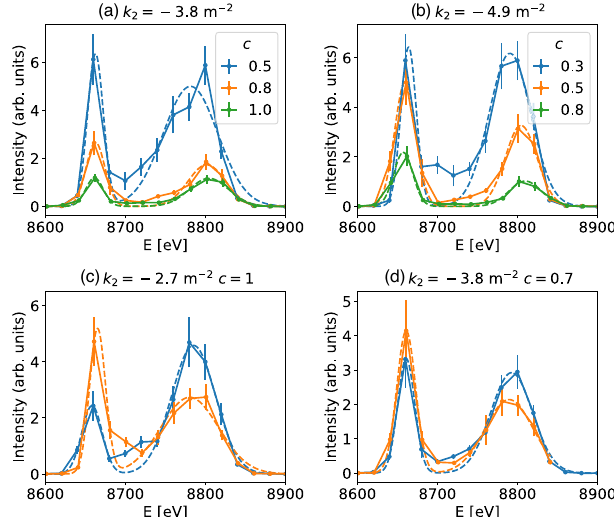
FIG. 5. Monochromator scans showing the tunability of the method. A and B: different sextupole strengths ( k 2 ) of the second sextupole in BC1 and orbit adjustments ( c ). C and D: two examples where the strength of a quadrupole in the EC is varied to balance the peak intensity of the two pulses (orange) with respect to the original cases